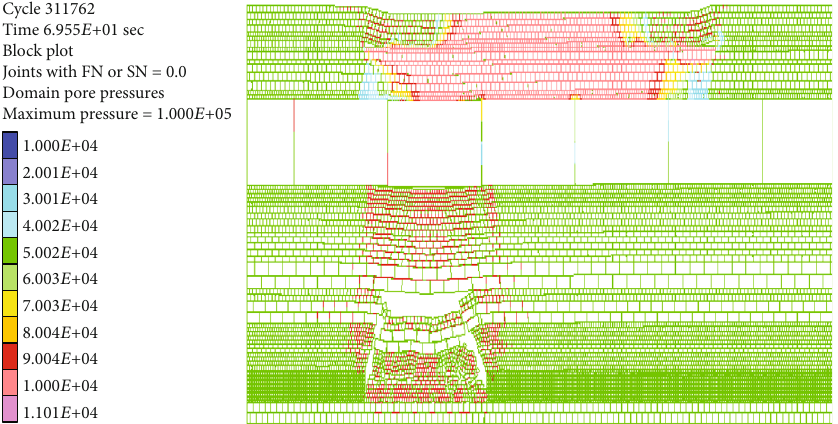
Figure 4: The pore pressure distribution in initial caving of #1 key stratum.